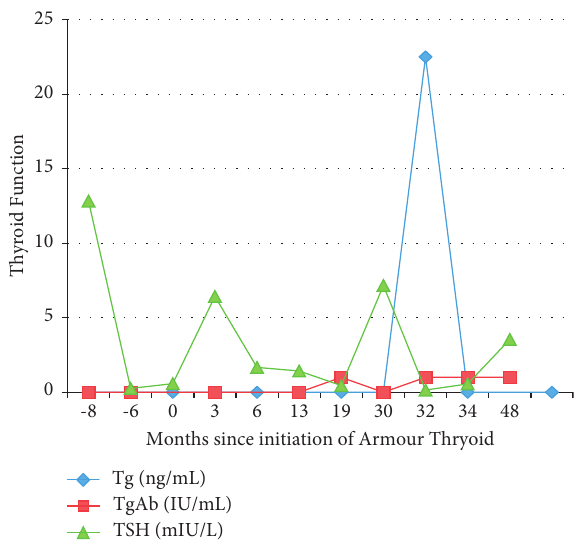
Figure 2: Trend of TSH and thyroglobulin results over time in case